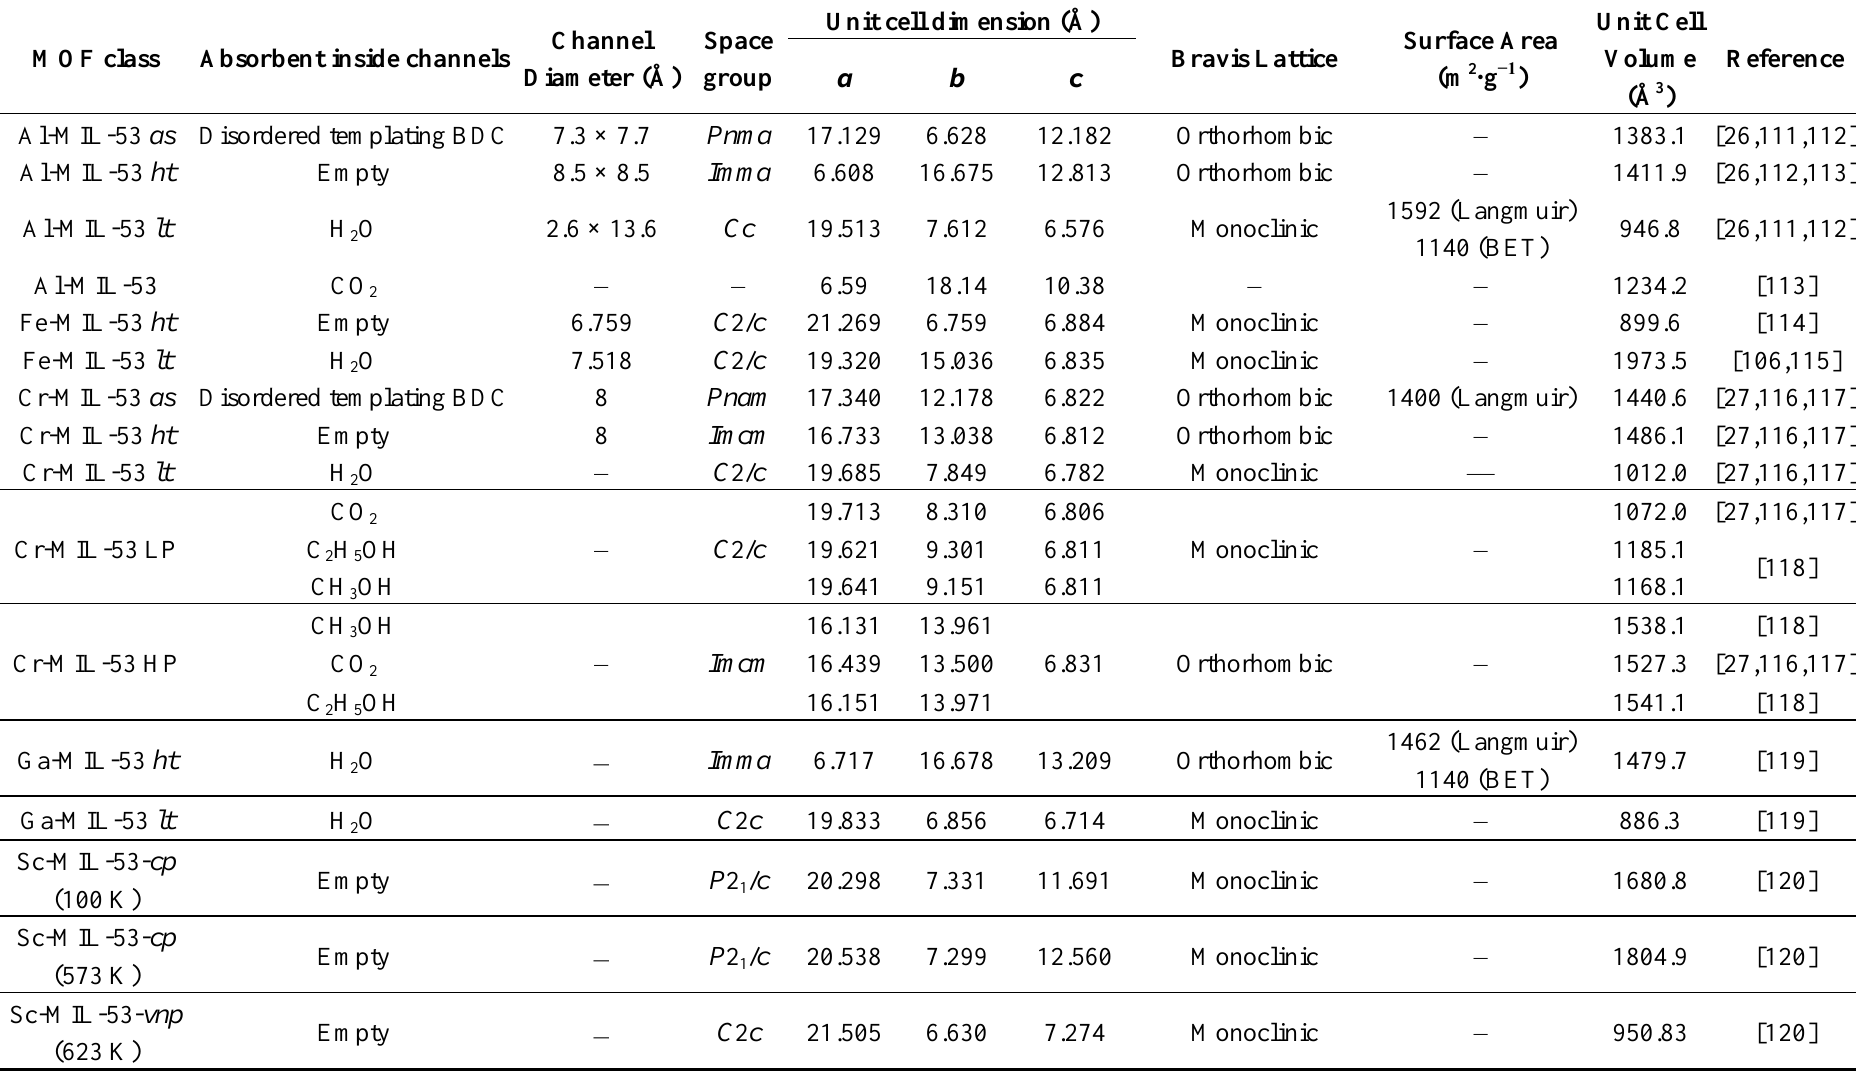
Table 3. Summary Physical Properties of “Breathing”